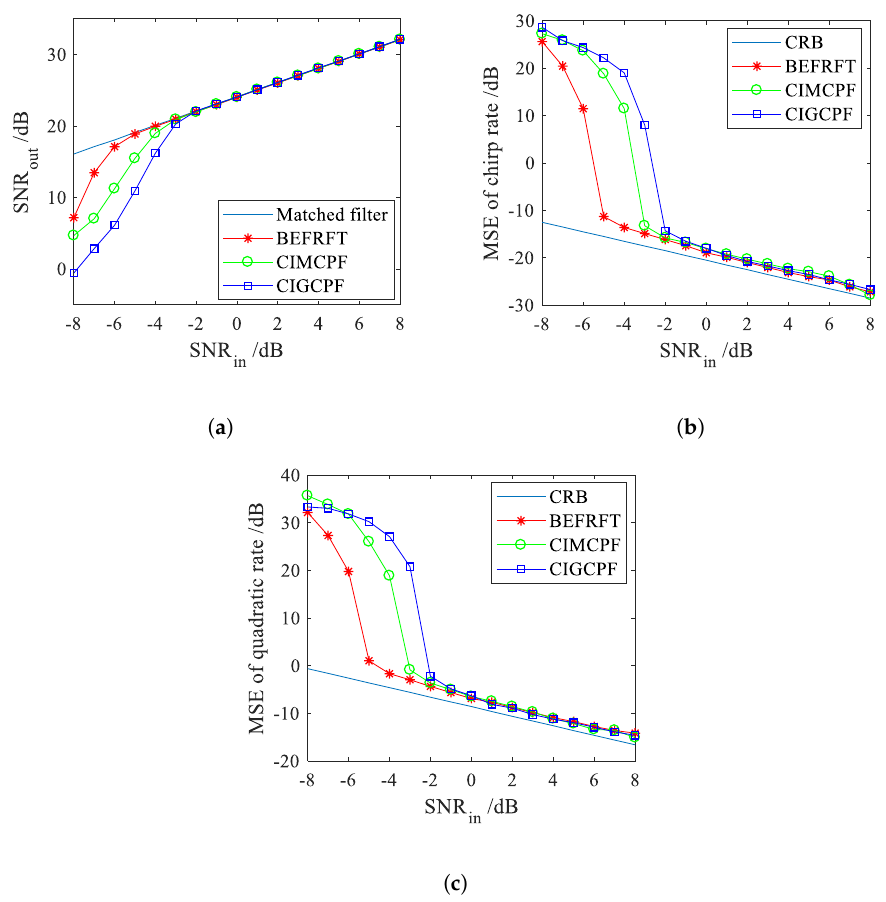
Figure 3. Antinoise performance. ( a ) Input-output signal-to-noise ratio (SNR) comparison. ( b ) Comparison of mean square errors (MSEs) of chirp rate. ( c ) Comparison of MSEs of quadratic chirp